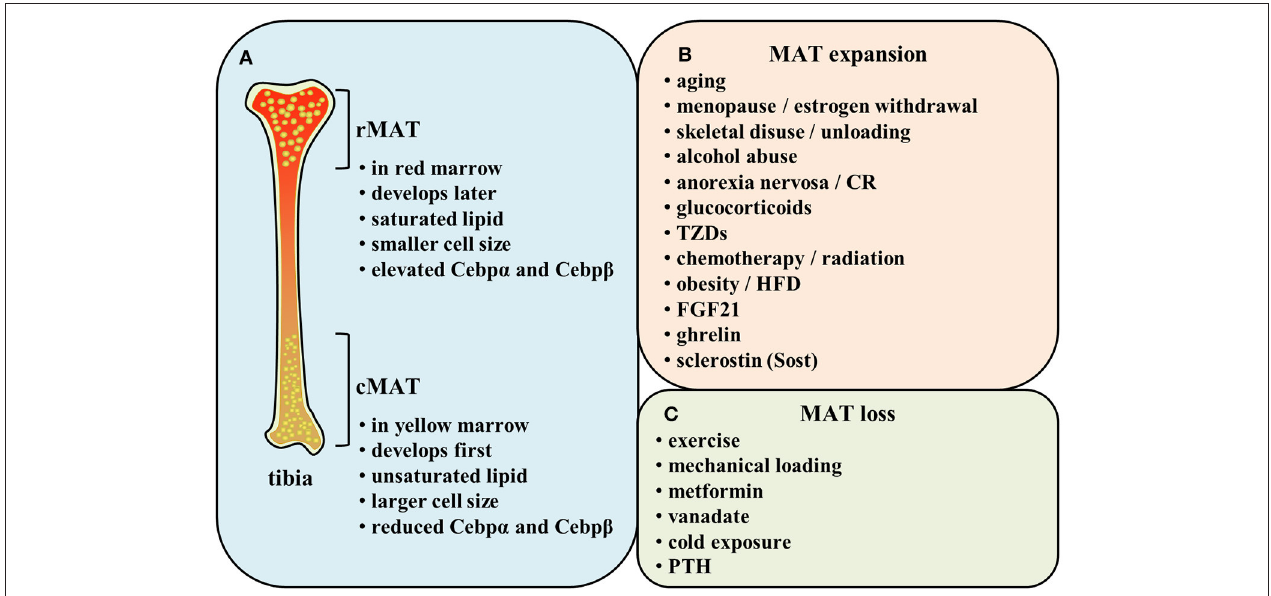
FIGURE 1 | (A) Comparison of rMAT and cMAT. (B,C) Regulatory factors of